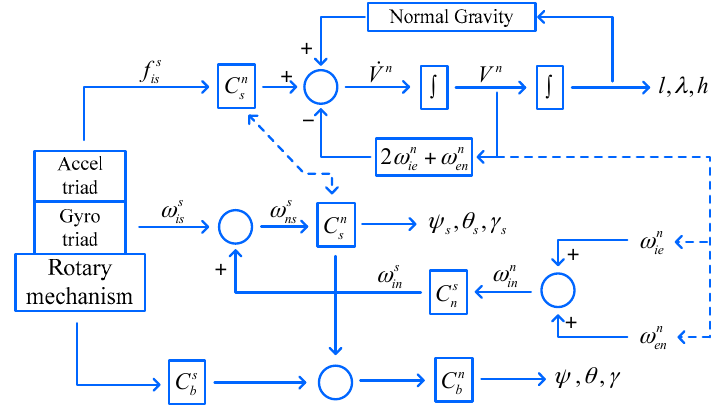
Figure 5. Flowchart of rotary semi-strapdown solution algorithm.